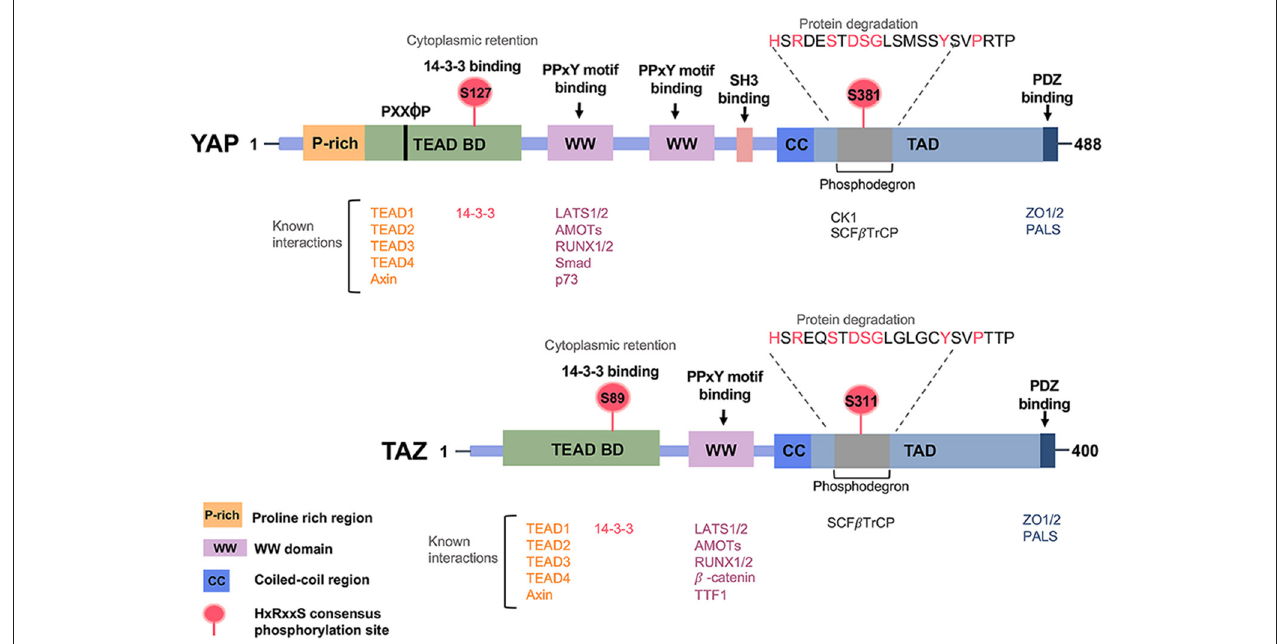
FIGURE 3 | Regulatory domains of the Hippo pathway effector proteins YAP/TAZ. Prominent regions include the WW domain(s), the coiled-coil (CC) domain, the SH3-binding domain, the TEAD transcription factor-binding domain, the transcriptional activation domain (TAD) and the PDZ-binding